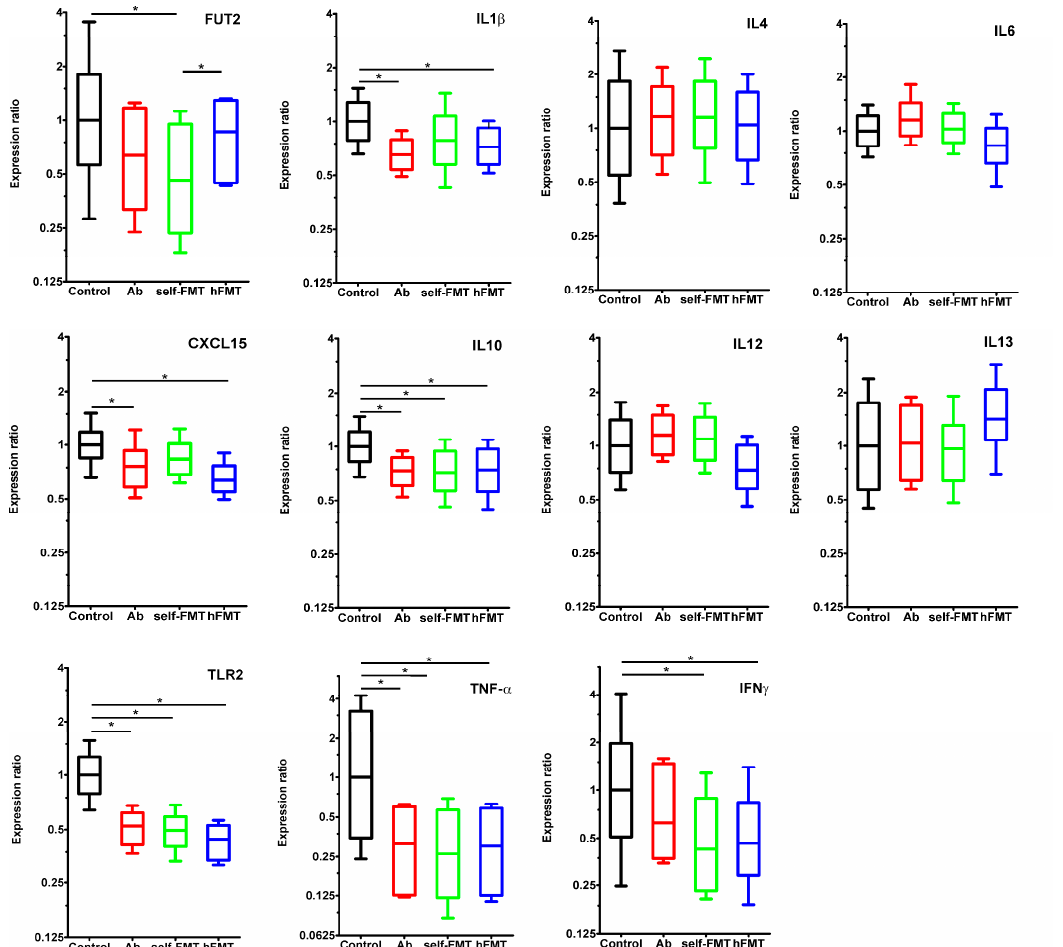
Figure 6. Differences in gene expression in the small intestine of infected mice. Expression of immune system mediators ( IL1 β , IL4, IL6, CXCL15, IL10, IL12, IL13, IFN γ , TNF α , and TLR2 ) and fucosyltransferase 2 ( FUT2 ) was determined by RT-qPCR in mice from the different groups at 7 dpi ( n = 5). The level of significance is indicated for control mice (* p < 0.05).